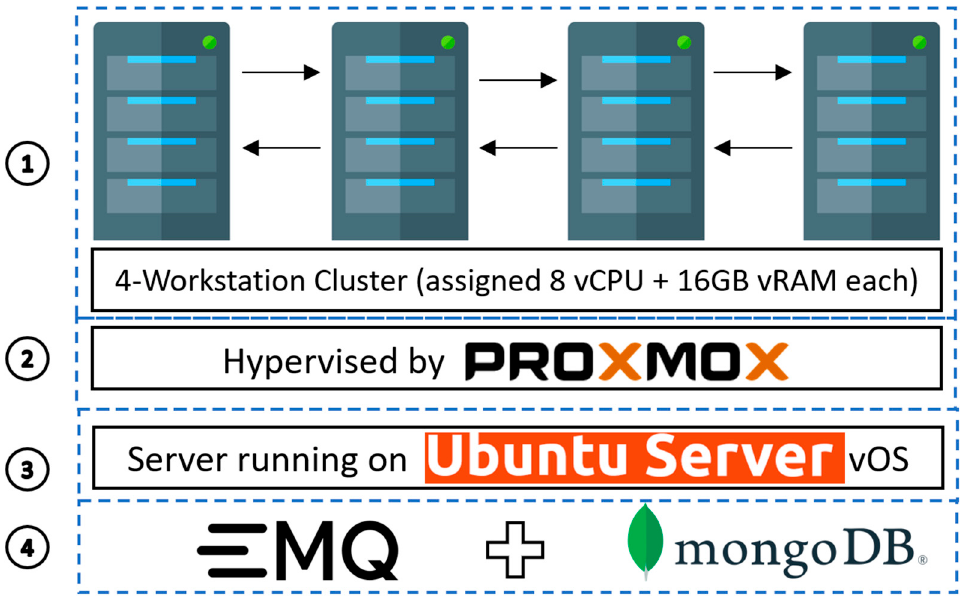
Figure 8. Labels 1–4 indicate the layers of the MQTT Server’s architecture. (1) Hardware: A workstation Cluster. (2) Virtualization Hypervisor: Proxmox assigns eight virtual nuclei of CPU and 16 GB of Virtual RAM from each workstation to the Clustered Virtual Machine running the Broker Services (3) OS: The Virtual Machine runs on the Ubuntu Server Virtual OS. (4) Services: EMQ and MongoDB.